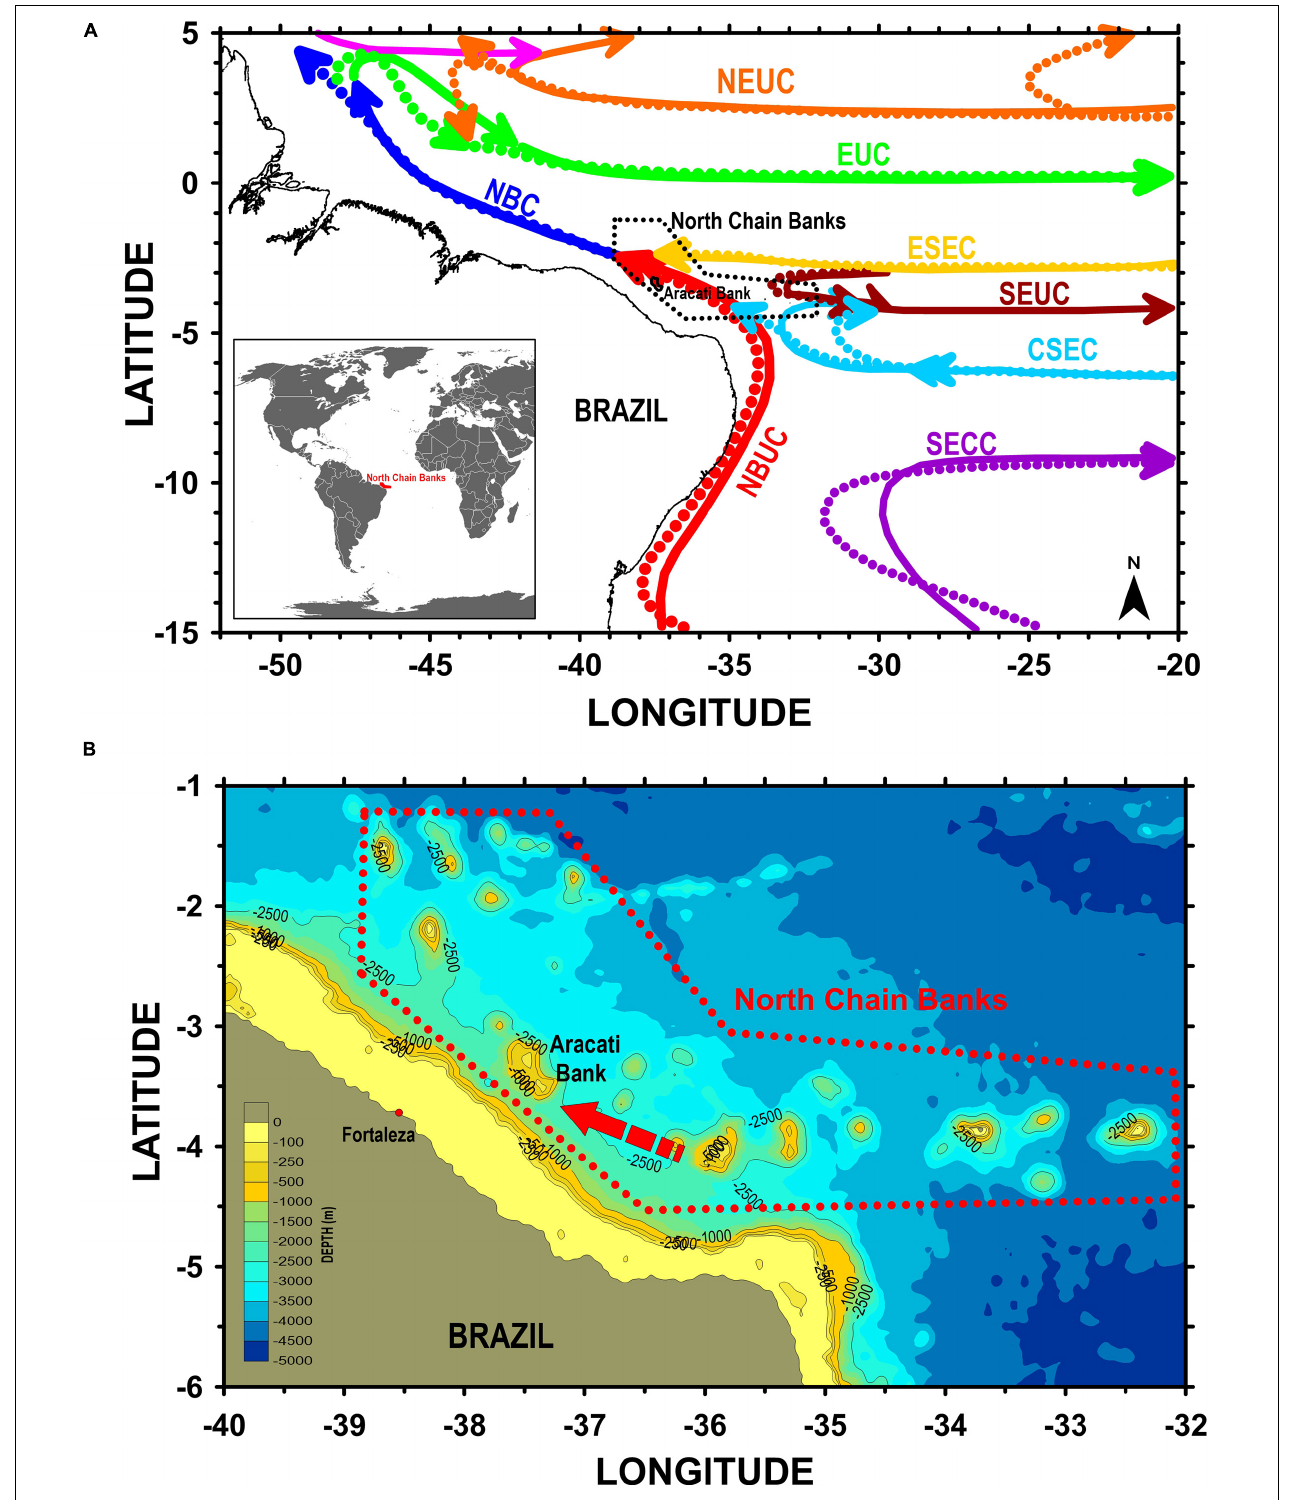
FIGURE 1 | Study area (A) general location view of the North Chain Banks and major currents at the top 100 m (solid lines) and at 100- to 500-m layers (dashed lines), both compiled from Stramma and England (1999). (B) Detailed view of the North Chain Banks with bathymetric contours and direction of prevailing winds (dashed arrow). NEUC, North Equatorial Undercurrent; NBC, North Brazil Current; EUC, Equatorial Undercurrent; ESEC, Equatorial South Equatorial Current; SEUC, South Equatorial Undercurrent; CSEC, Central South Equatorial Current; NBUC, North Brazil Undercurrent; SECC, South Equatorial Countercurrent.